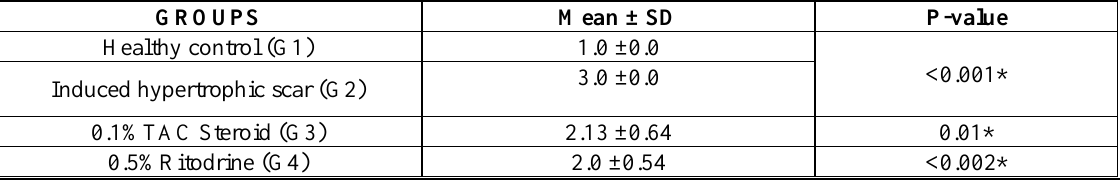
Table2. Mean collagen III scores in control and study groups